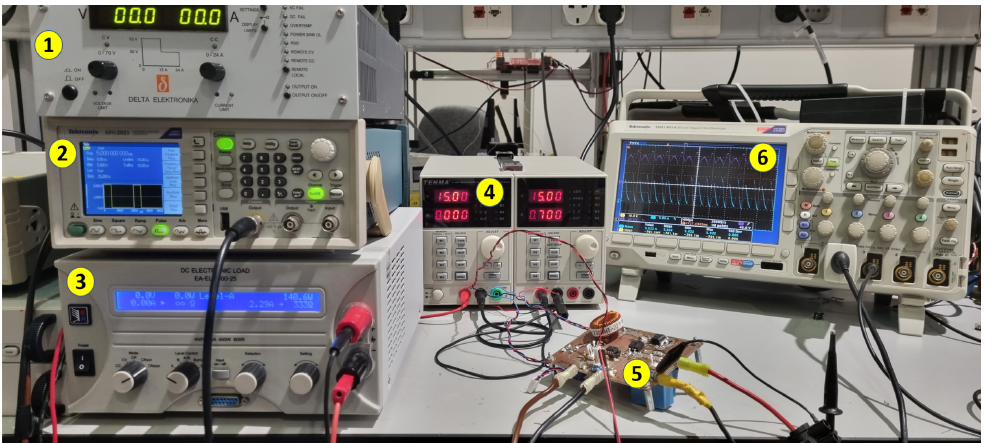
Figure 3. The experimental setup to observe period-doubling bifurcation in an open-loop boost converter with a CPL. (cid:196) Boost converter circuit.